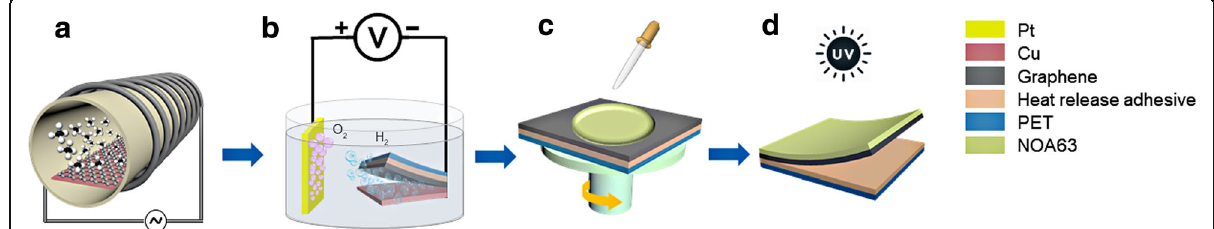
Fig. 1 Design overview of synthesis and transfer processes for graphene film. a The CVD growth of graphene on Cu foil; CH 4 was using as the carbon source. b Illustration of the first transfer process of bubbling off graphene from Cu substrate; PET coated with heat release adhesive (HRA) was used as support layer. The electrolyte was NaOH aqueous solution, Pt was used as anode, and PET/HRA/graphene/Cu foil was cathode. c , d Illustration of secondary-transferring graphene electrode. Drip and spin coat the UV-curable polymer NOA63 on graphene/HRA/PET substrate, then solidify NOA63 film and left it off from graphene/HRA/PET